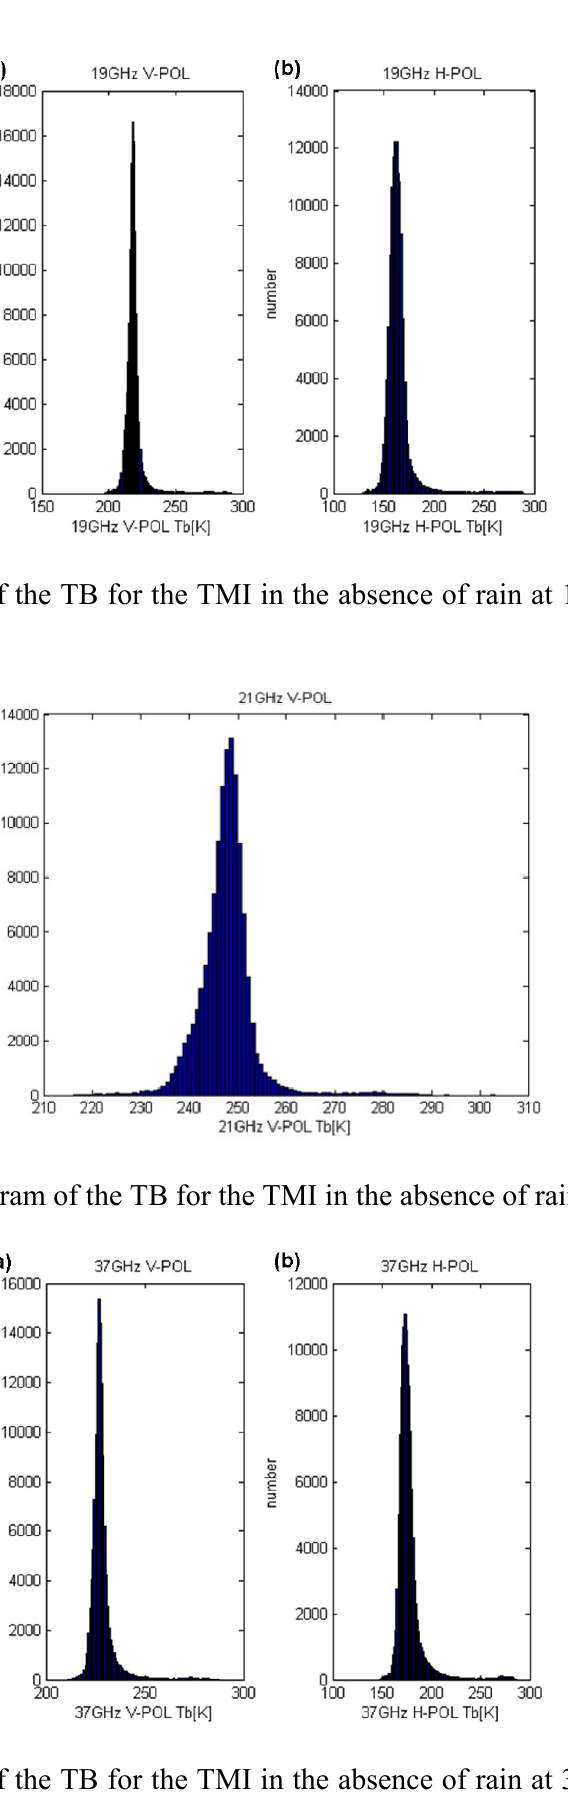
Figure 7. Histograms of the TB for the TMI in the absence of rain at 37 GHz: ( a ) TB10V and ( b )